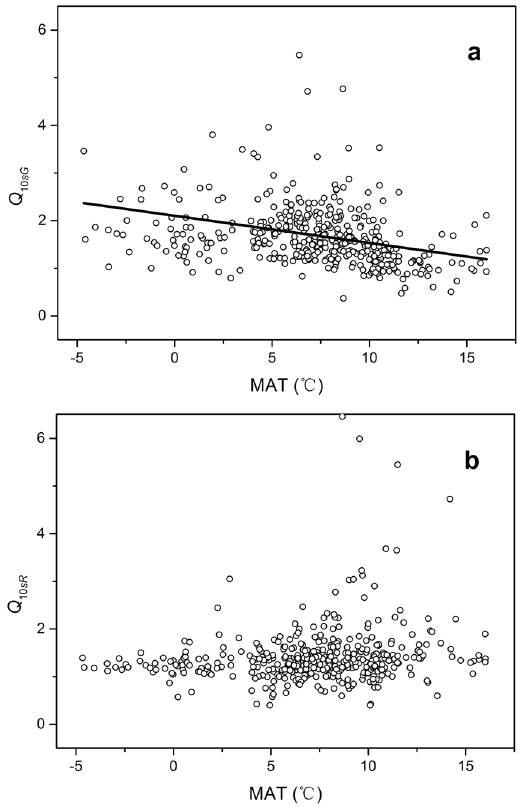
Figure 2. Relationships between intrinsic temperature sensitivity indexes of ( a ) gross primary production rate (GPP, Q 10 sG ) and ( b ) respiration rate (RE, Q 10 sR ) vs. mean annual temperature (MAT) (GPP: Pearson’s r = − 0.31, n = 403, F = 41.80, P < 0.0001; RE: r = − 0.034, n = 403, F = 2.65, P = 0.49). The solid line in ( a ) represents the linear regression line.